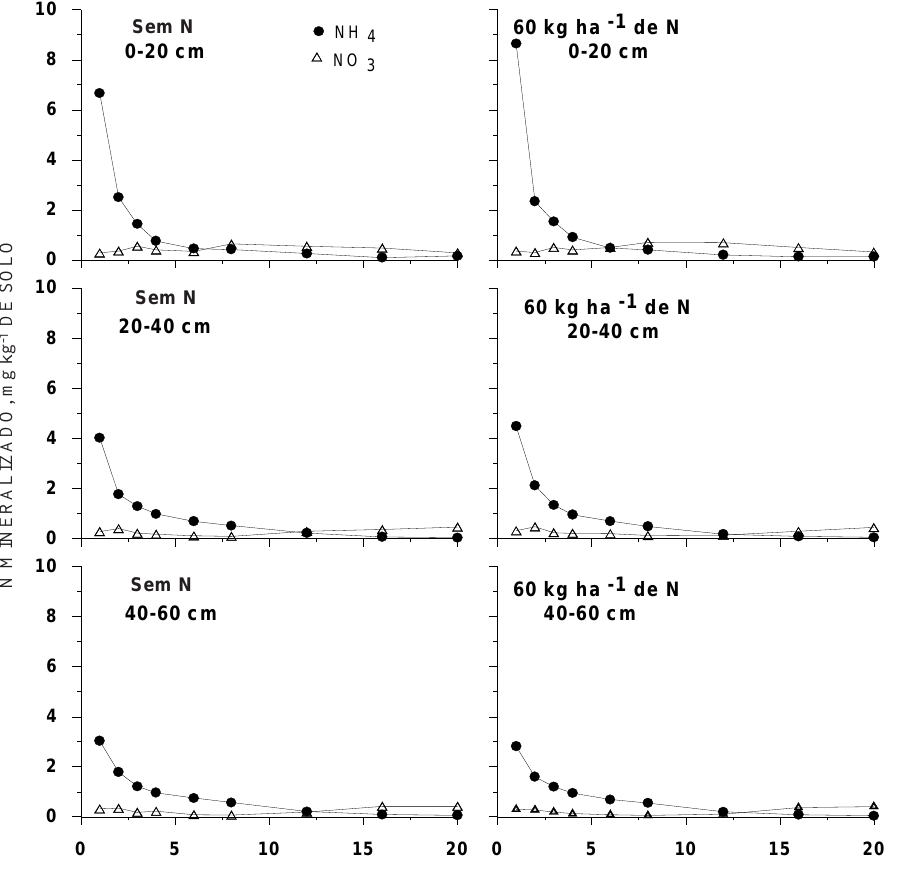
Figura 3. Produção média semanal de N- NH 4+ e de N- NO 3- por período de incubação, em amostras retiradas das profundidades de 0-20, 20-40 e 40-60 cm de um solo PVA, cultivado com cana-de-açúcar, sem N e com 60 kg ha -1 de N. (médias de amostras retiradas com diferentes épocas de